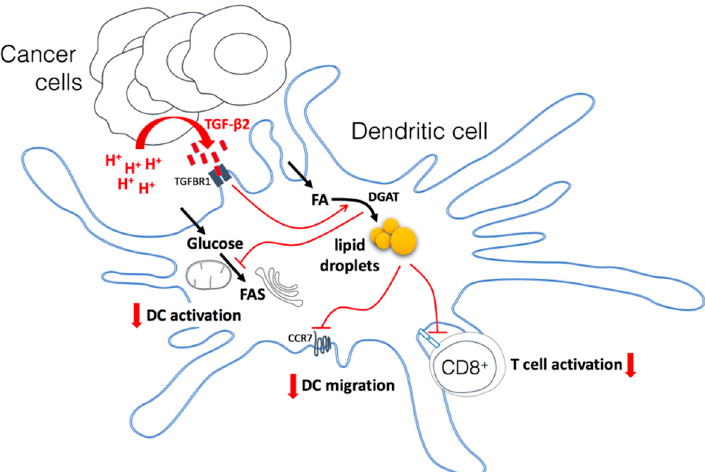
Figure 7. Model depicting how the acidic tumor microenvironment promotes TGF- β 2 secretion by cancer cells which in turn leads to lipid droplet (LD) accumulation and profound metabolic rewiring in dendritic cells (DCs). DCs exposed to a TGF- β 2-containing mesothelioma acidic milieu exhibit a net increase in the uptake of fatty acids that accumulate as triglycerides into LDs, as well as a dramatic reduction in glucose metabolism. The consequences are a deficit in both DC migratory potential and activation as well as a decrease in T cell activation. Inhibition of TGF- β 2 signaling but also diacylglycerol O-acyltransferase (DGAT), the last enzyme involved in triglyceride synthesis, has the potential to restore DC activity and anticancer immune response. TGFBR1: TGF-beta type I receptor inhibitor; CCR7: C-C chemokine receptor type 7; FAS: fatty acid synthesis.